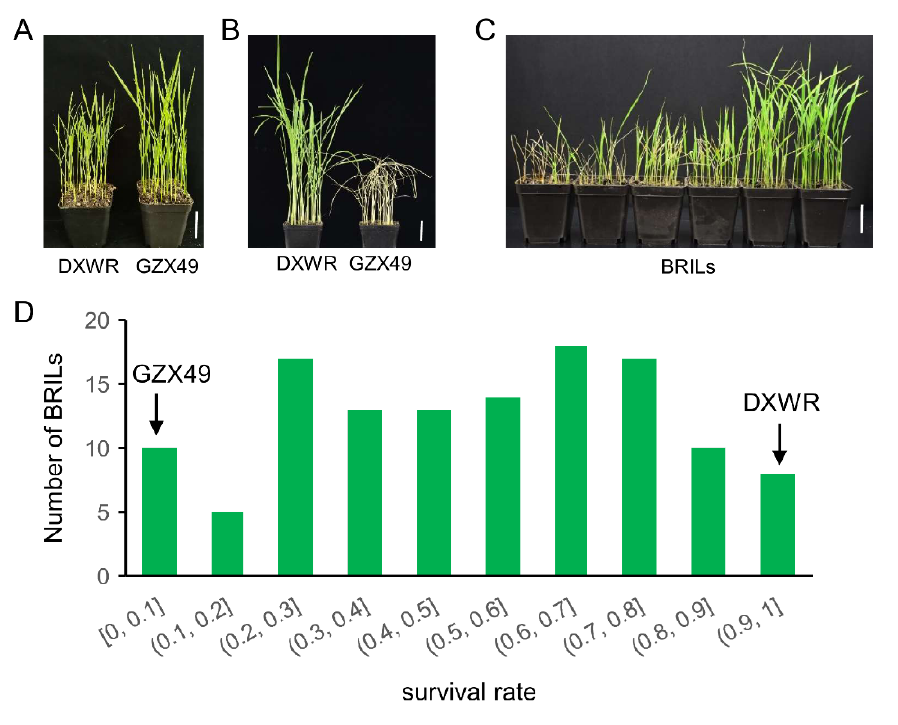
Figure 2. Phenotypic identification of seedling for cold tolerance. ( A , B ) represent the phenotypes of GZX49 and DXWR before and after cold treatment, respectively. ( C ) Phenotypes of some lines of the BRIL population after cold treatment. The scale bar of ( A – C ) means 5 cm. ( D ) Frequency distribution of seedling survival rate after cold treatment. Arrows indicate the means of parental lines GZX49 and DXWR.